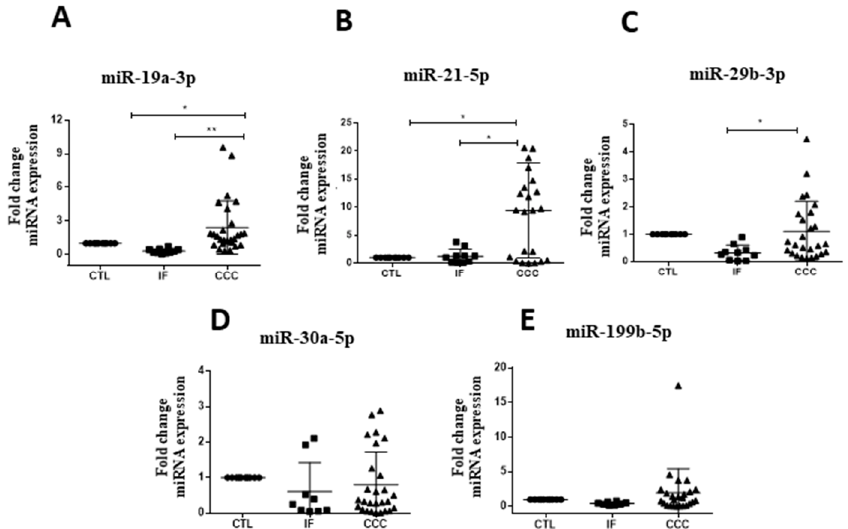
Figure 1. MicroRNA validation in serum of chronic Chagas disease subjects and healthy controls. Healthy controls (CTL), n = 10, Indeterminate form (IF), n = 10, and chronic Chagas cardiomyopathy (CCC), n = 28, were evaluated by RT-qPCR, ( A ) miR-19a-3p, ( B ) miR-21-5p and ( C ) miR-29b-3p, ( D ) miR-30a-5p and ( E ) miR-199b-5p, normalized by miR-93 and miR-16. One-way ANOVA followed by Newman-Keuls post-test. * p < 0.05.